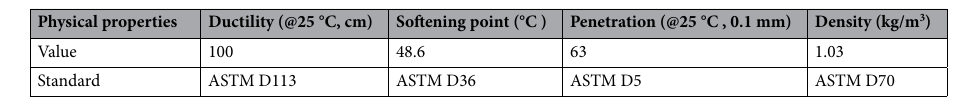
Table 3. Physical properties of bitumen